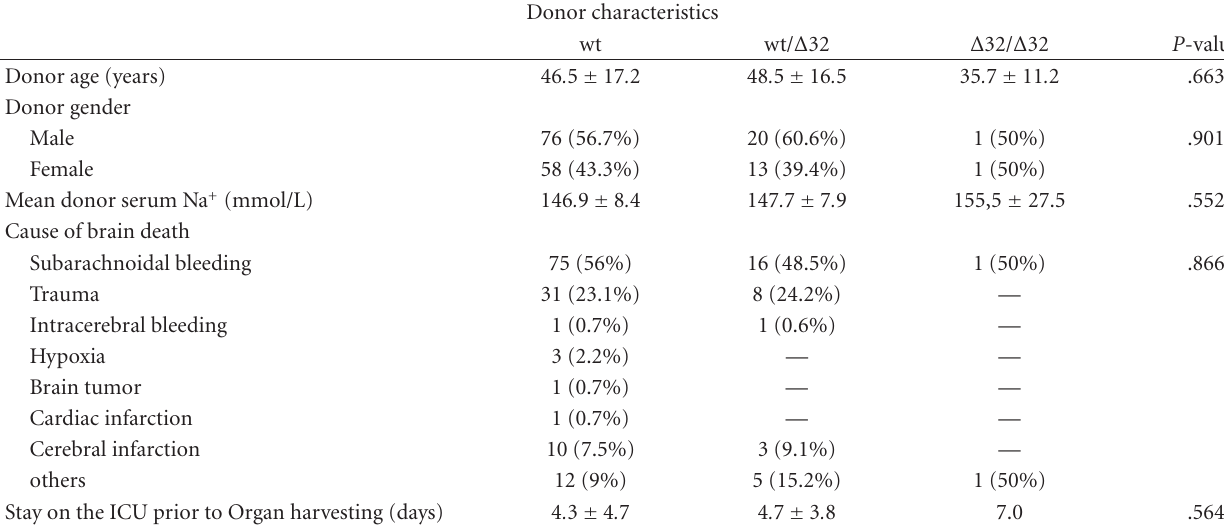
Table 2: Donor characteristics. ICU: intensive care unit; wt/wt: wild-type CCR-5; wt/ Δ 32: heterozygous CCR-5 Δ 32; Δ 32/ Δ 32: homozygous CCR-5 Δ 32.